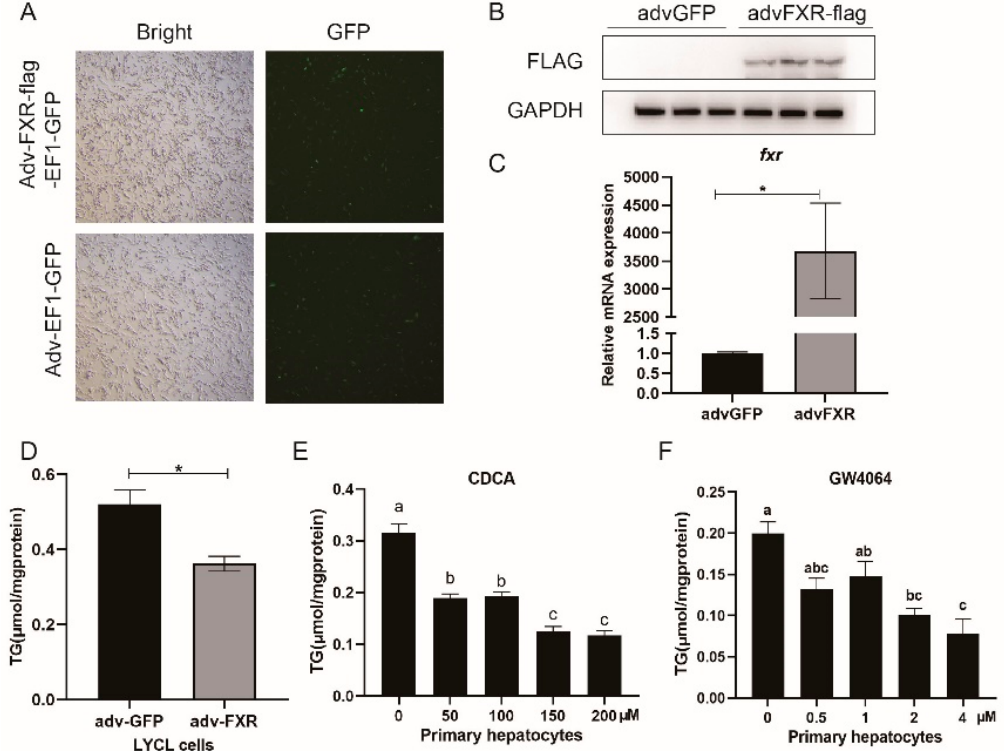
Figure 3. Effects of FXR overexpression or ligand-mediated FXR activation on the TG content of LYCL cells and primary hepatocytes of large yellow croakers: ( A – C ) Fluorescence analysis, immunoblots, and qRT-PCR assays for FXR in LYCL cells infected by croaker fxr adenovirus; ( D – F ) TG content of LYCL cells with overexpression of FXR or after treatment with CDCA and GW4064. Data are shown as means ± SEMs ( n = 3) and were analyzed using Duncan’s multiple range test and Student’s t -test. The letters a–c indicate that there is a significant difference between means, * p < 0.05.